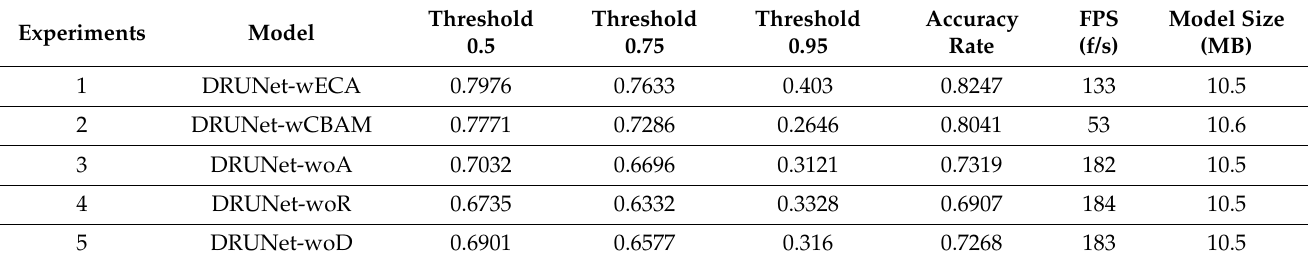
Table 1. The table shows the results of the ablation experiment, where the threshold indicates the different OKS thresholds, the corresponding value is the proportion of the number of test samples satisfying the threshold to the total number of test samples, and accuracy rate indicates the ratio of the number of test samples with the distance between the predicted coordinates and the real coordinates to the number of test samples with the radius of the inner tangent circle of the target ground truth less than